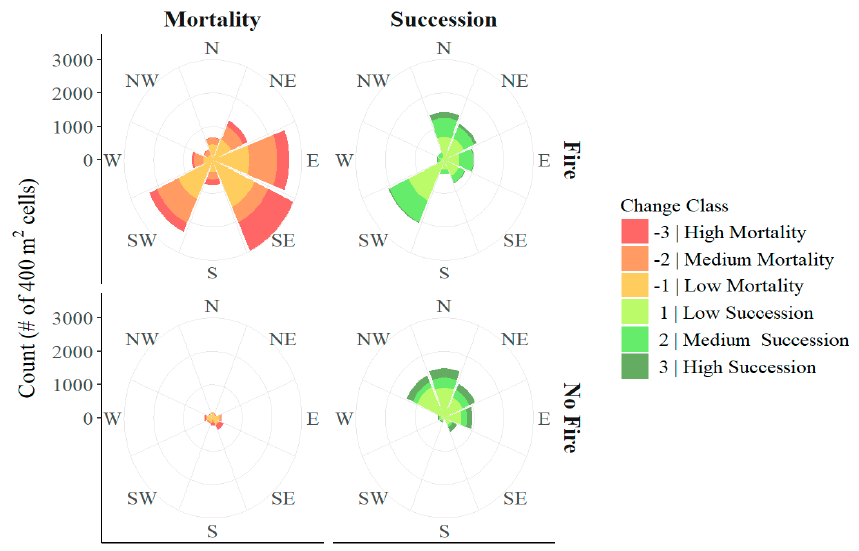
Figure 6. Mortality and succession in WCW over the period 1914–2006, factored by exposure to